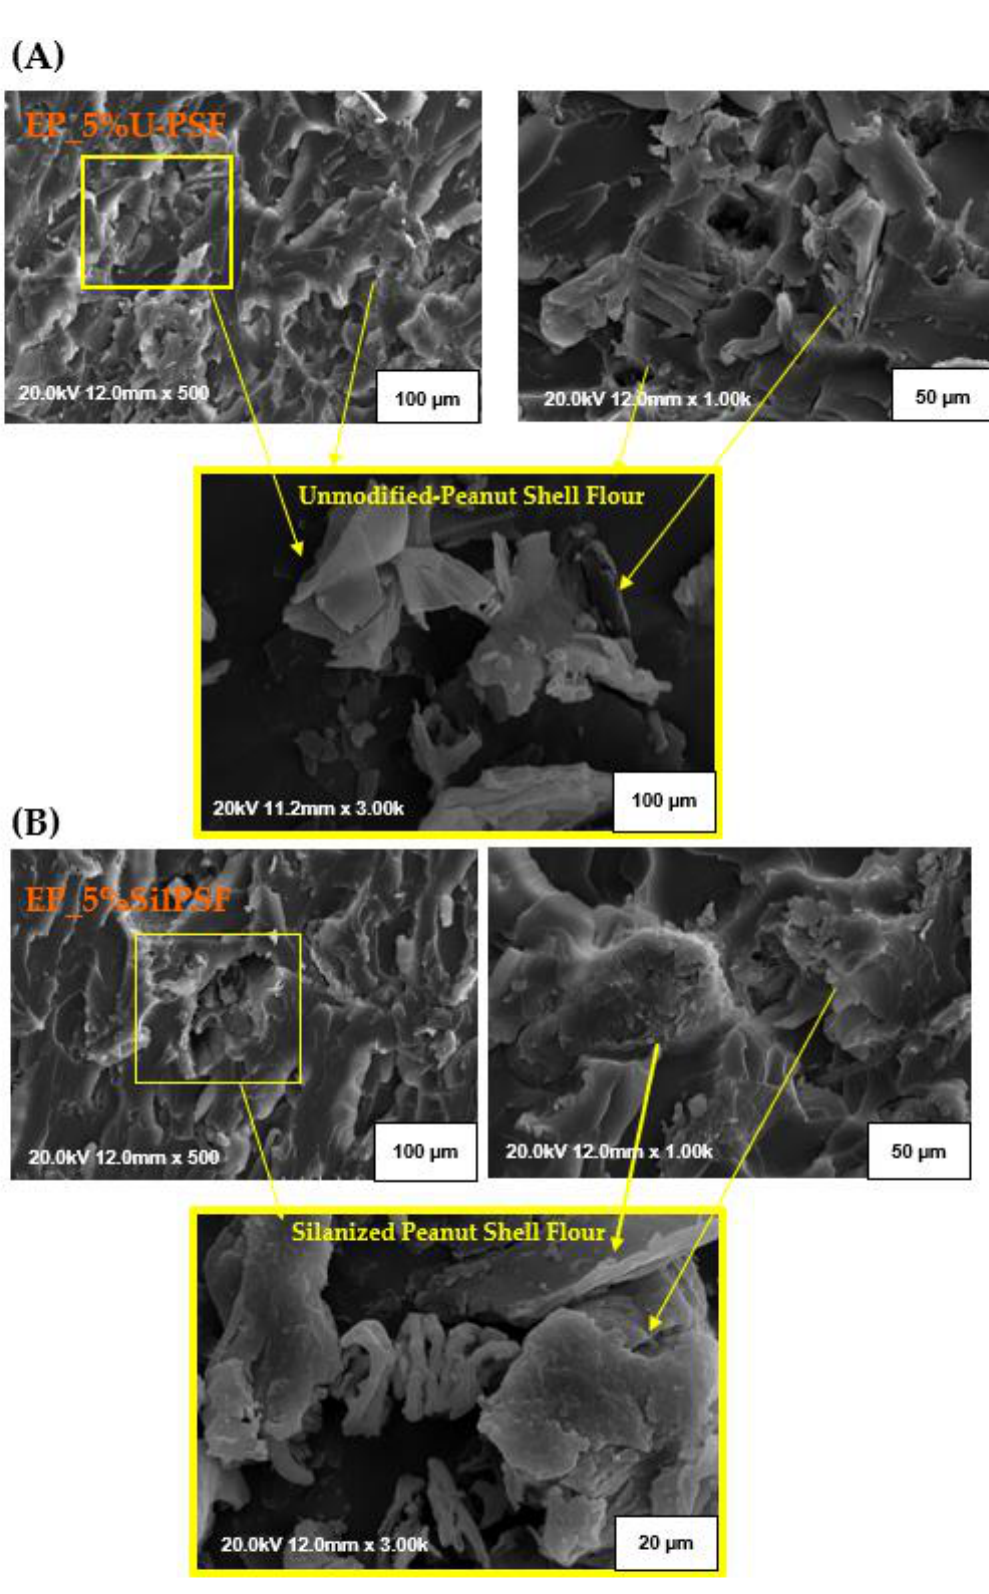
Figure 7. SEM micrographs of the impact fracture surface of the epoxy composites of EP_5%U-PSF composition filled with 5 wt.% of unmodified peanut shell flour ( A ), and EP_5%SilPSF composition filled with 5 wt.% of silanized peanut shell flour ( B ).